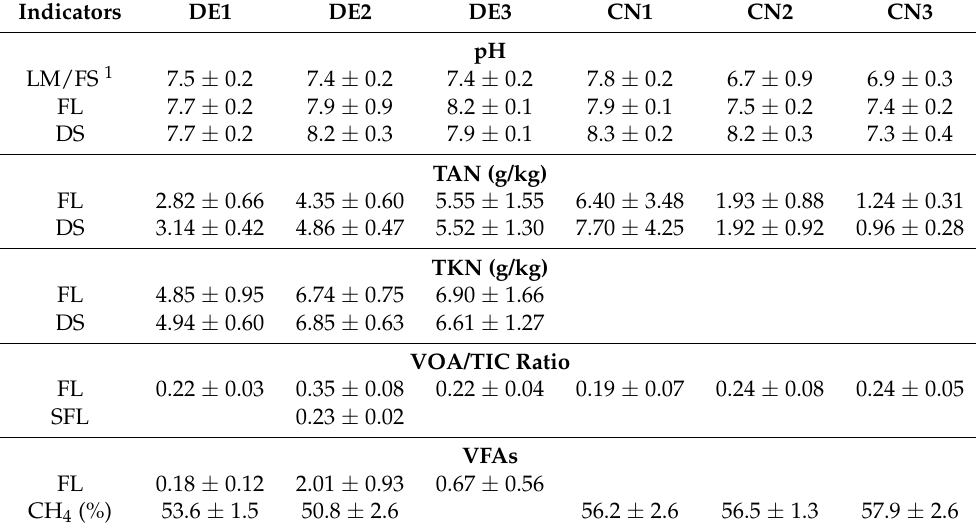
Table 4. Process stability indicators of German (DE) and Chinese (CN) biogas plants (BGPs), including the pH value, concentration of total ammonia nitrogen (TAN), total Kjeldahl nitrogen, VOA/TIC ratio, and total volatile acids (VFAs) in fermentation liquid (FL) and digestate slurry (DS). Results are averages ± SD. Indicators DE1 DE2 DE3